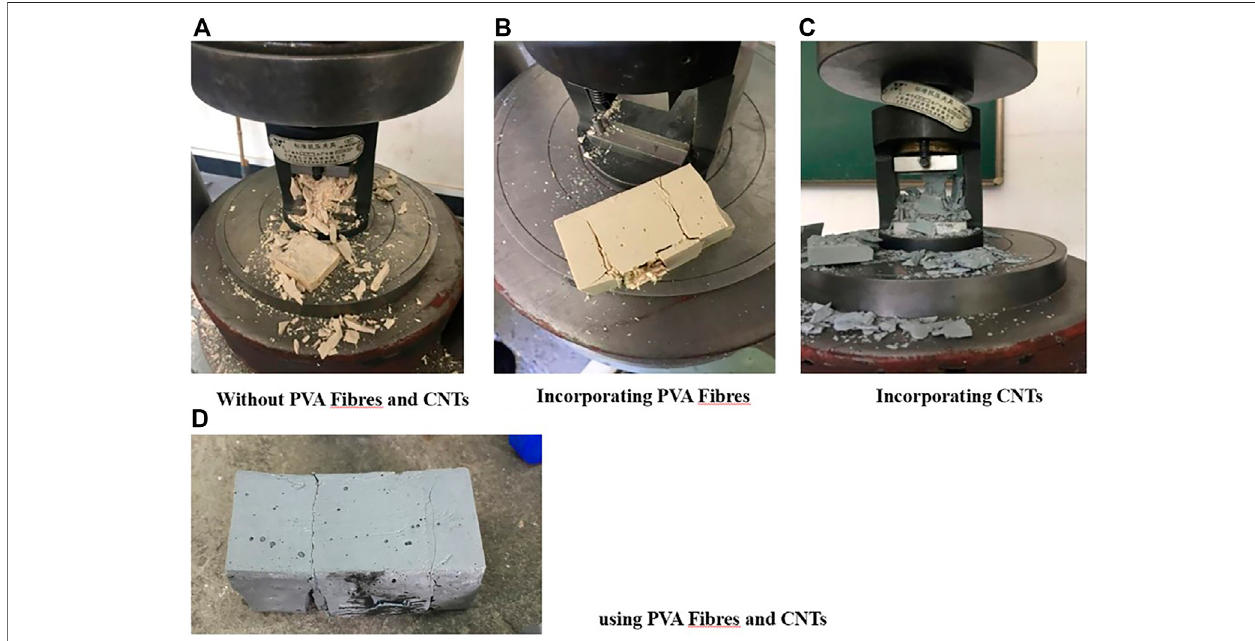
FIGURE 5 | Failure modes of compressive strength test of geopolymer.